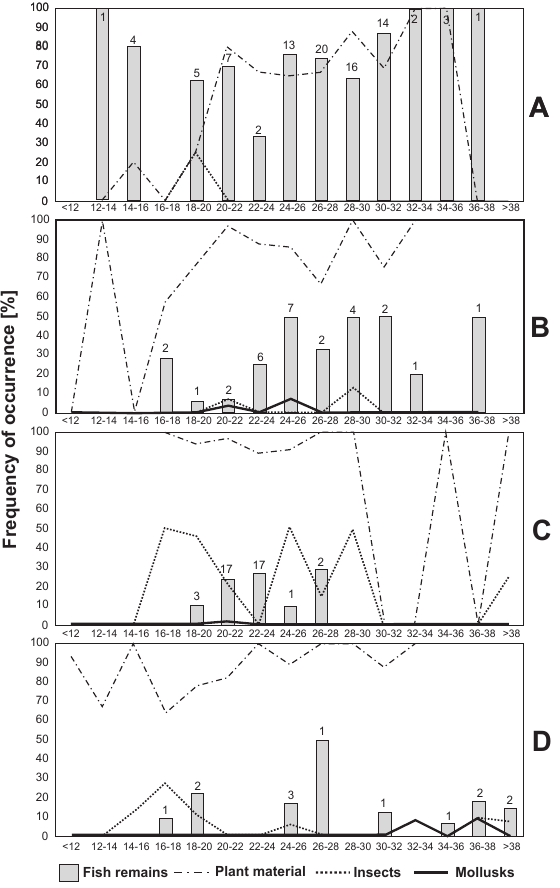
Figure 5. The frequency of occurrence of the main food types found in the gut contents of the different size classes of the Scar- dinius acarnanicus specimens taken from A : Lake Trichonis (with light), B : Lake Trichonis (without light), C : Lake Ozeros, and D : Lake Amvrakia. The numbers of Scardinius acarnanicus individuals with fish remains in their gut content are given.